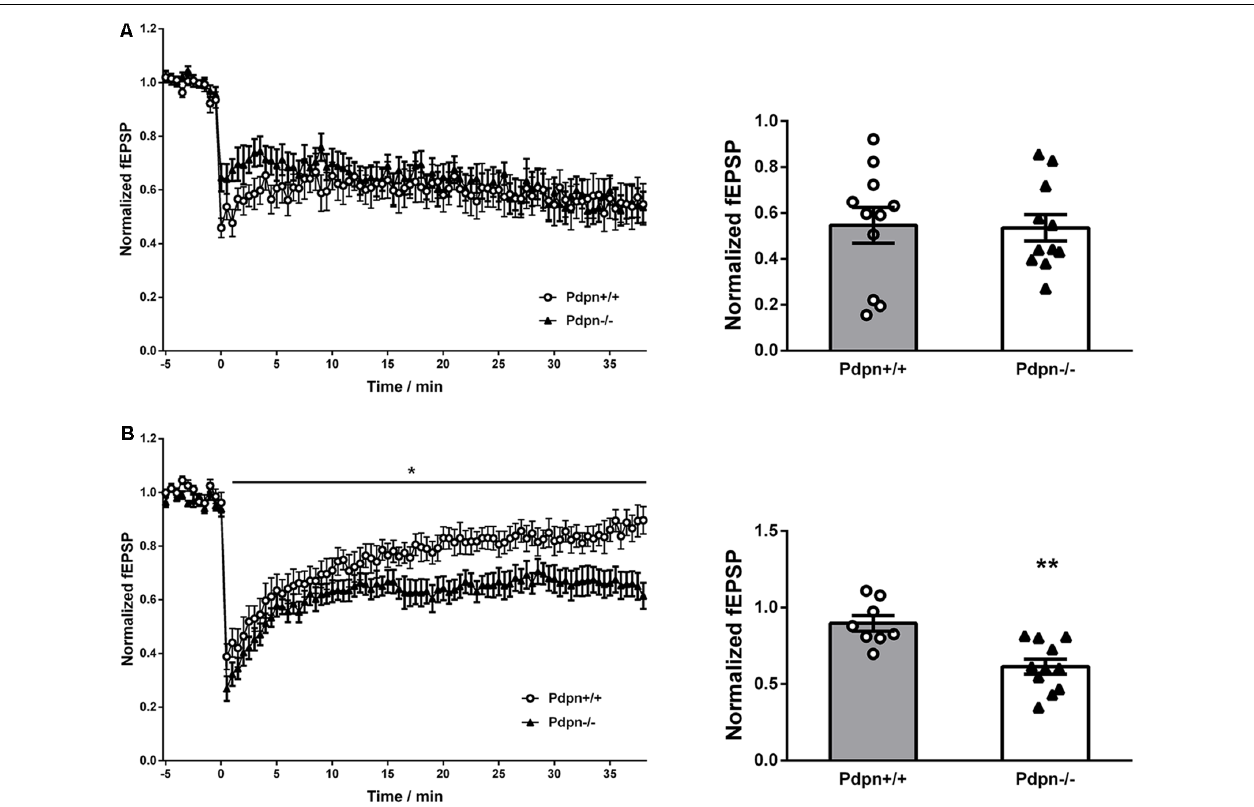
FIGURE 2 | Podoplanin deletion alters long-term depression (LTD) selectively in the hippocampal DG. (A) Temporal courses of averaged slopes of fEPSP in CA3-Schaffer collateral-CA1 synapses (left panel) showed a strong main significant effect of time ( ∗∗∗∗ P < 0.0001, F ( 76,1520 ) = 3.72, n = 11), no significant main effect of genotype ( P = 0.6, F ( 1,20 ) = 0.36, n = 11) and a significant interaction between time and genotype ( ∗∗∗ P = 0.0004, F ( 76,1520 ) = 1.7). Corresponding bar graphs of the end-time points (right panel) showed no significant differences between Pdpn + / + and Pdpn − / − ( t ( 20 ) = 0.1124, P = 0.9, n = 11). ( B ) Temporal courses of averaged slopes of fEPSP in medial perforant pathway (MPP) of DG (left panel) showed a strong main significant effect of time ( ∗∗∗∗ P < 0.0001, F ( 75,1275 ) = 27.87, n = 8–11), a moderate significant main effect of genotype ( ∗ P = 0.03, F ( 1,17 ) = 5.99, n = 8–11) and a significant interaction between time and genotype ( ∗∗∗∗ P < 0.0001, F ( 75,1275 ) = 1.88). Corresponding bar graphs of the end-time points (right panel) showed significant differences between Pdpn + / + and Pdpn − / − ( t ( 17 ) = 3.93, ∗∗ P = 0.002, n = 8–11). Data are displayed as mean ±